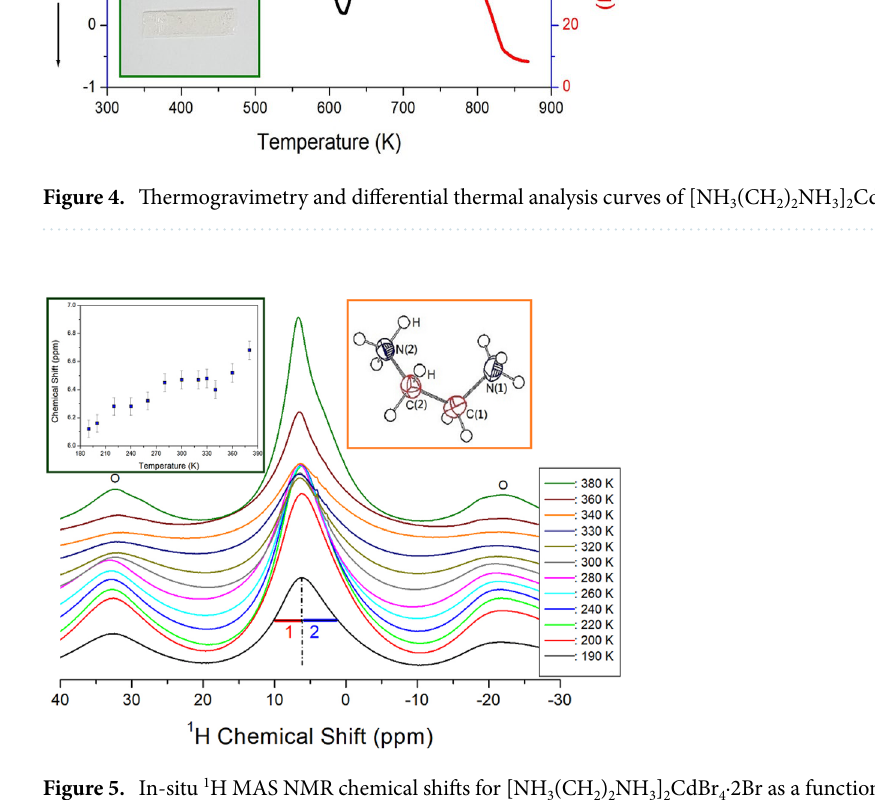
Figure 5. In-situ 1 H MAS NMR chemical shifts for [NH 3 (CH 2 ) 2 NH 3 ] 2 CdBr 4 ·2Br as a function of